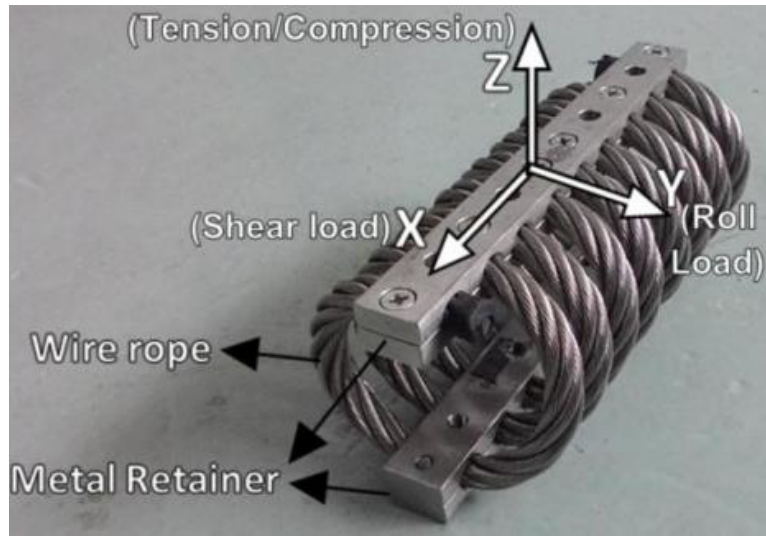
Figure 1. Wire rope isolator (WRI) and its loading modes (Reprinted from ref. [10]).